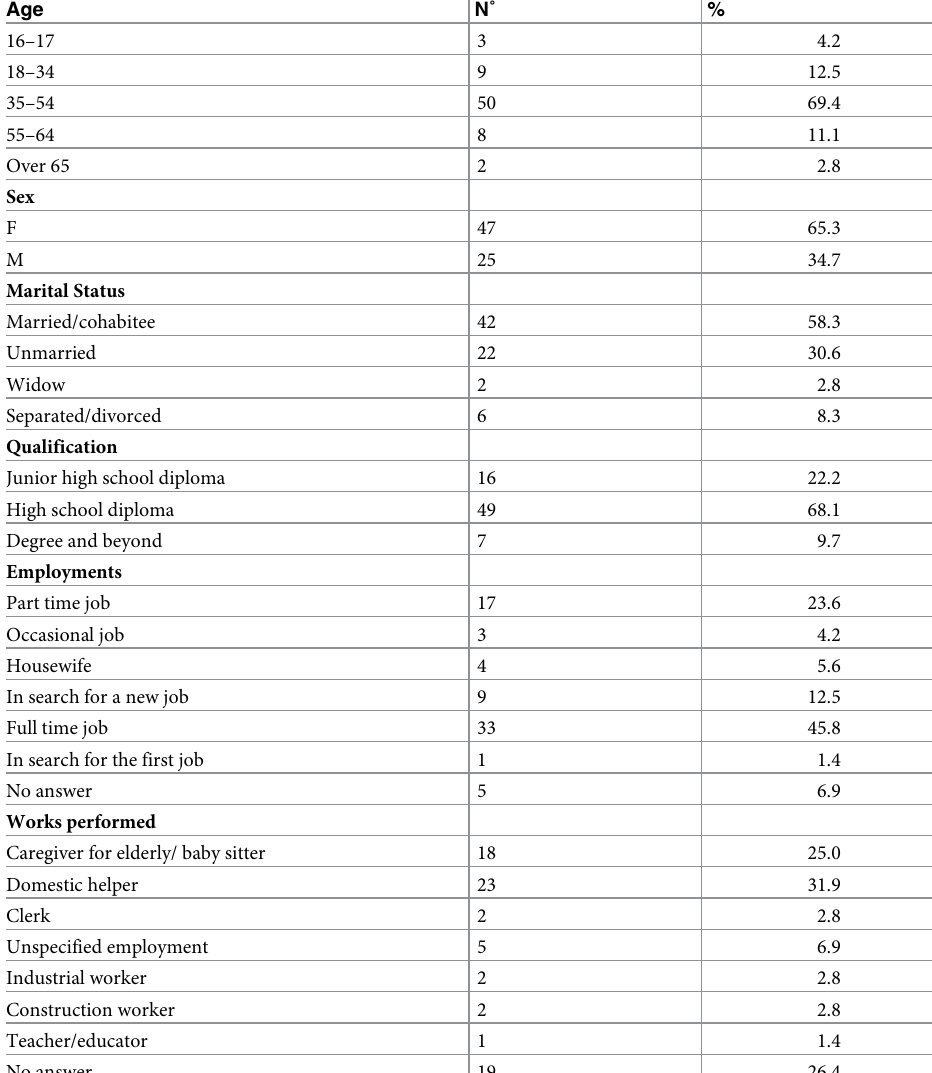
Table 2. Distribution of selected characteristics for participants in anthropological study on Chagas Disease